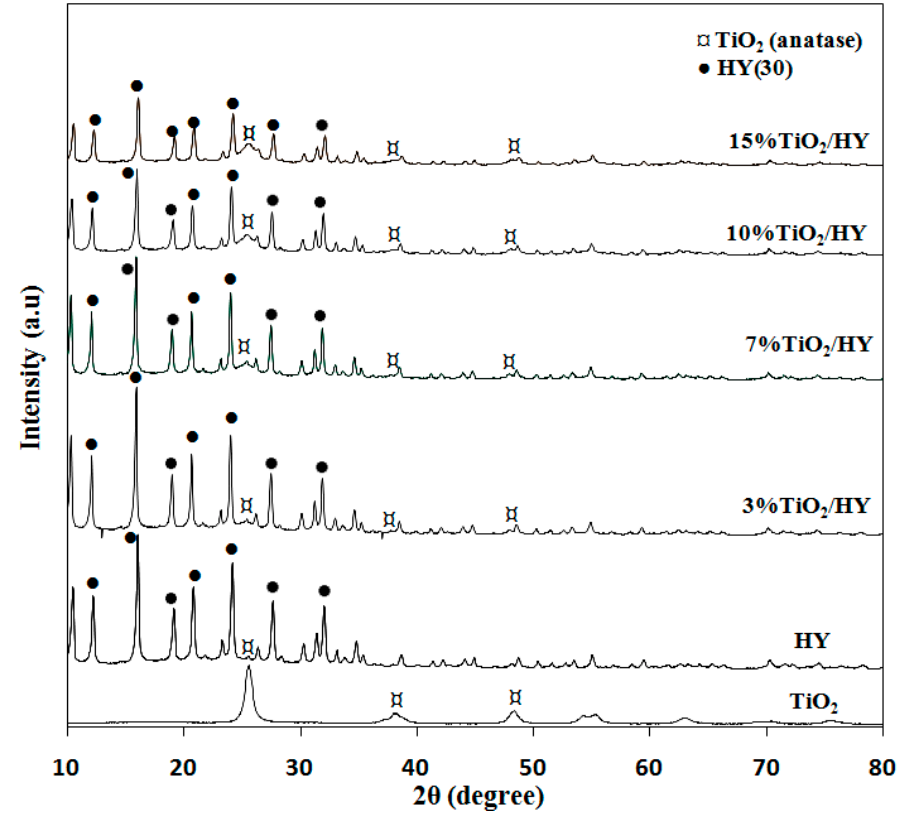
Figure 2. XRD patterns of TiO 2 , HY and 3, 7, 10, and 15 wt% TiO 2 /HY, from bottom to top, respectively.